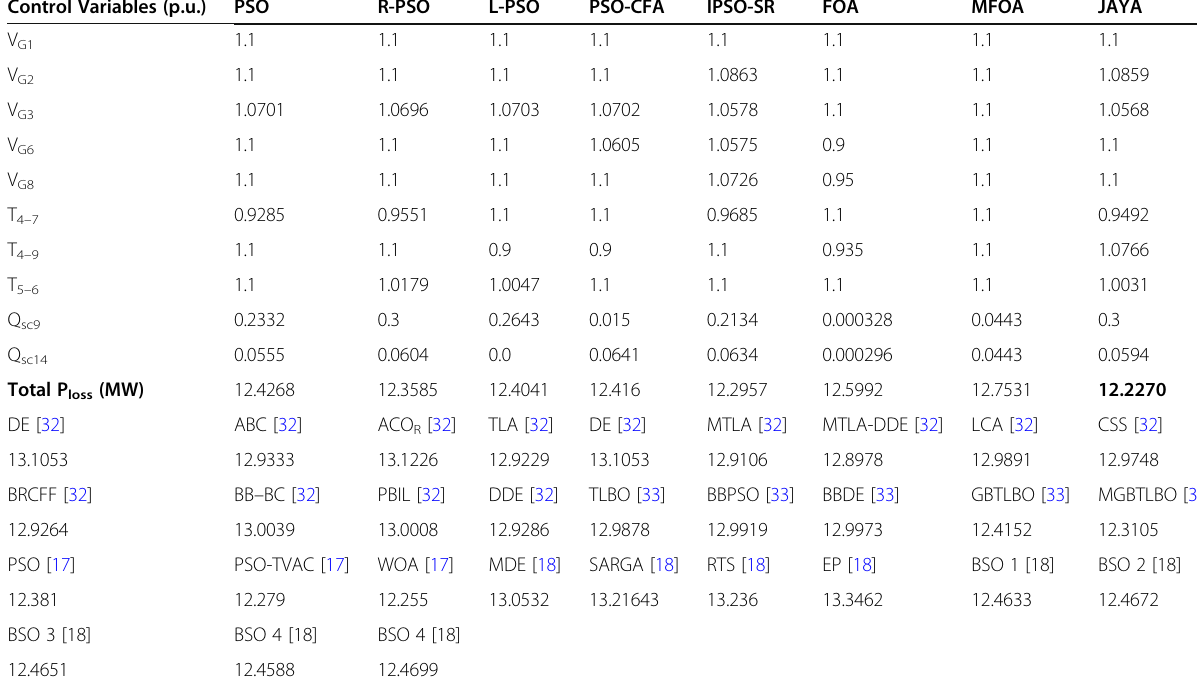
Table 3 Simulation results on the IEEE 14 bus system using different algorithms without DG injection Control Variables (p.u.)